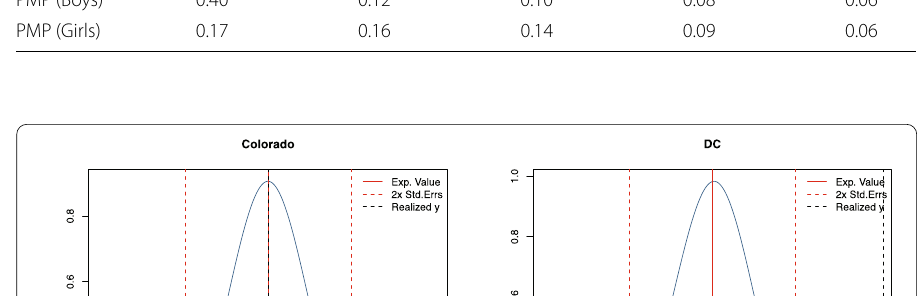
Fig. 4 Boys (top row) and girls (bottom row) posterior forecast density plots: Colorado and